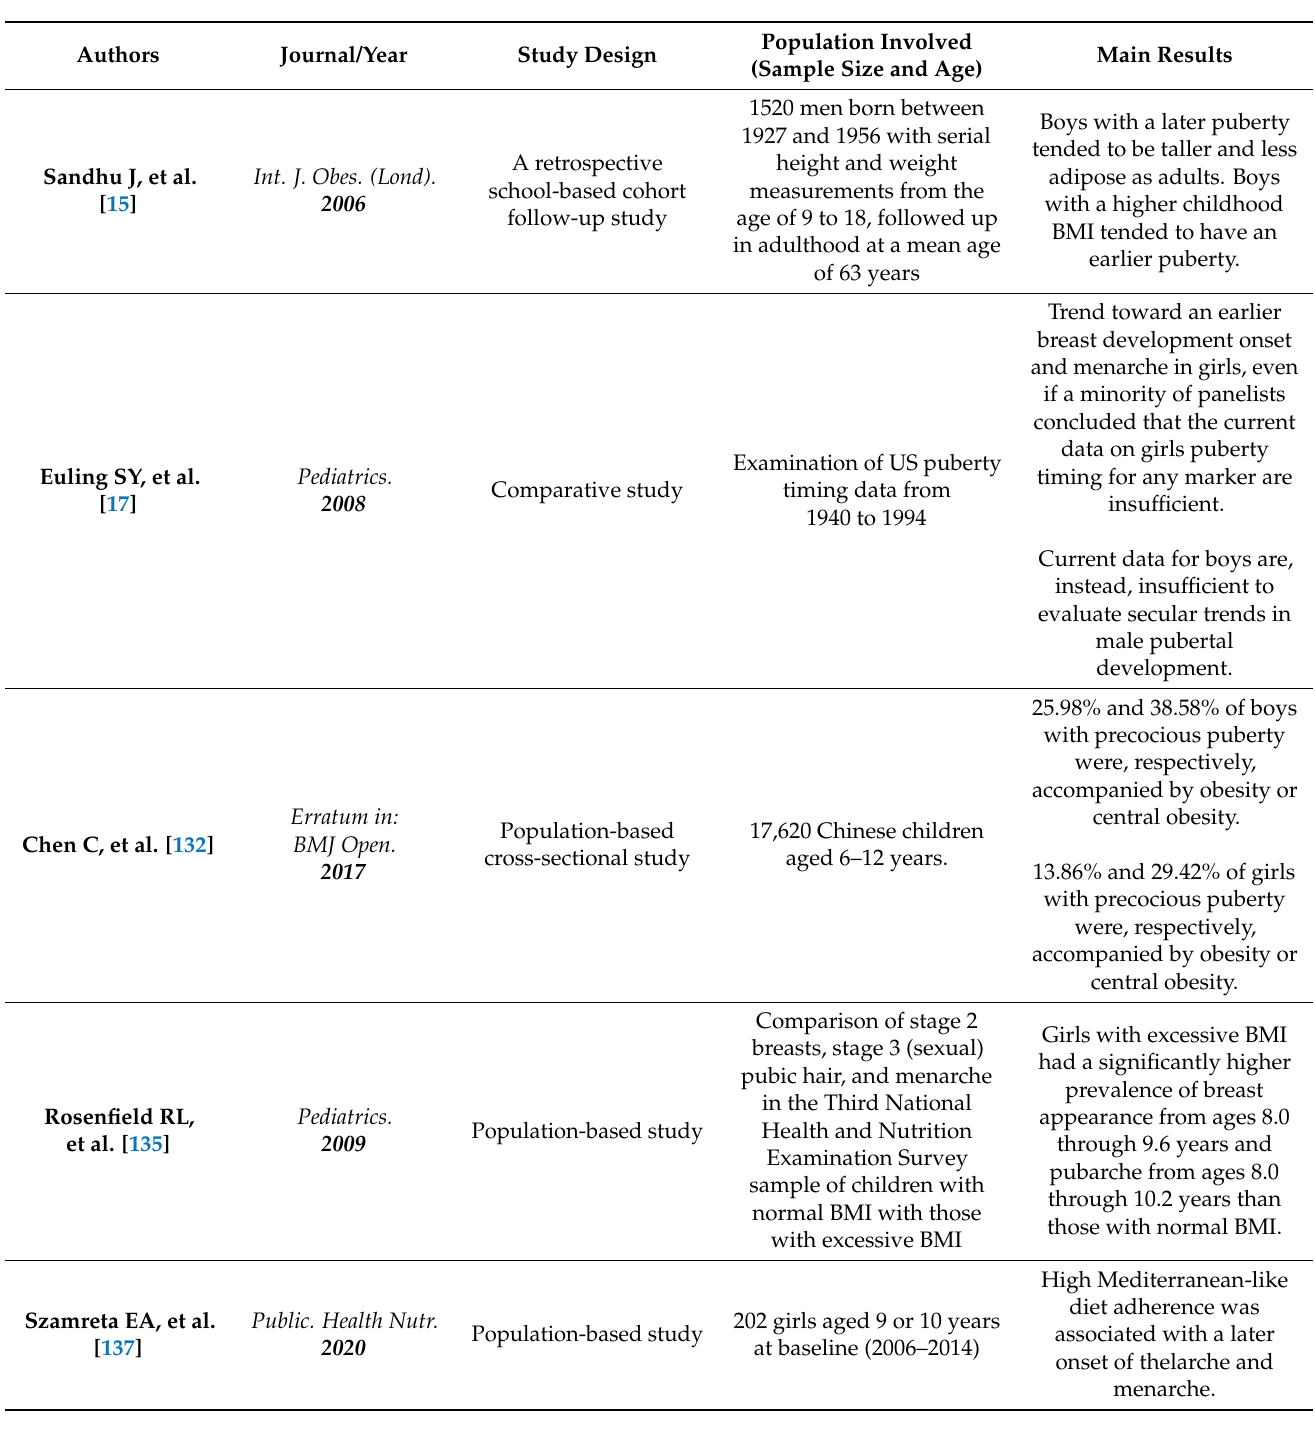
Table 1. Manuscripts analyzed to discuss the epidemiological evidence on the relation between HF content, obesity, and pubertal